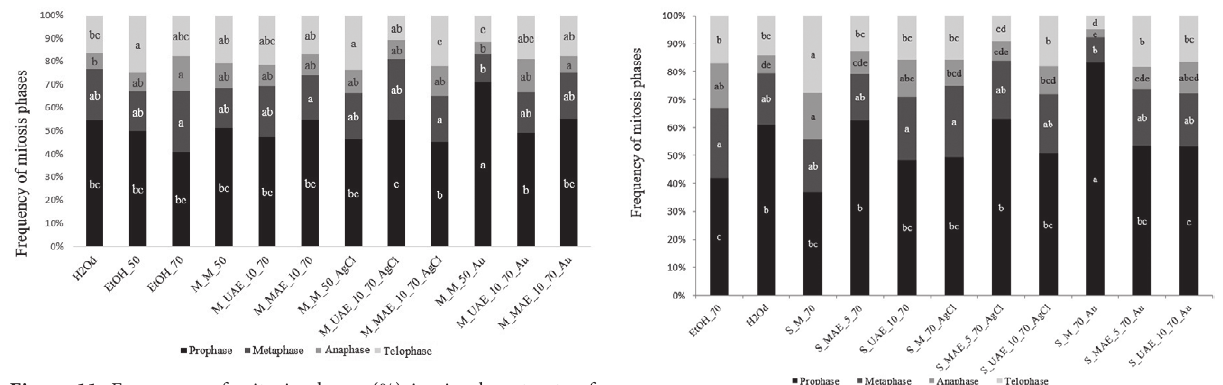
Figure 11. Frequency of mitosis phases (%) in simple extracts of M. officinalis and nanostructured phytochemical complexes (a–c: interpretation of the significance of the differences, by means of the Duncan test, p < 0,05).